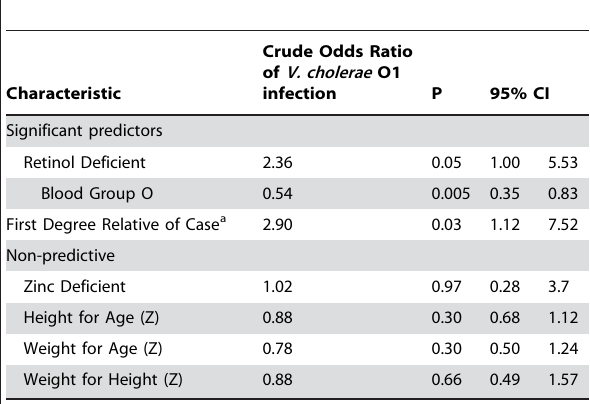
Table 4. Other non-immunologic predictors of susceptibility to infection with V. cholerae O1 El Tor in household contacts